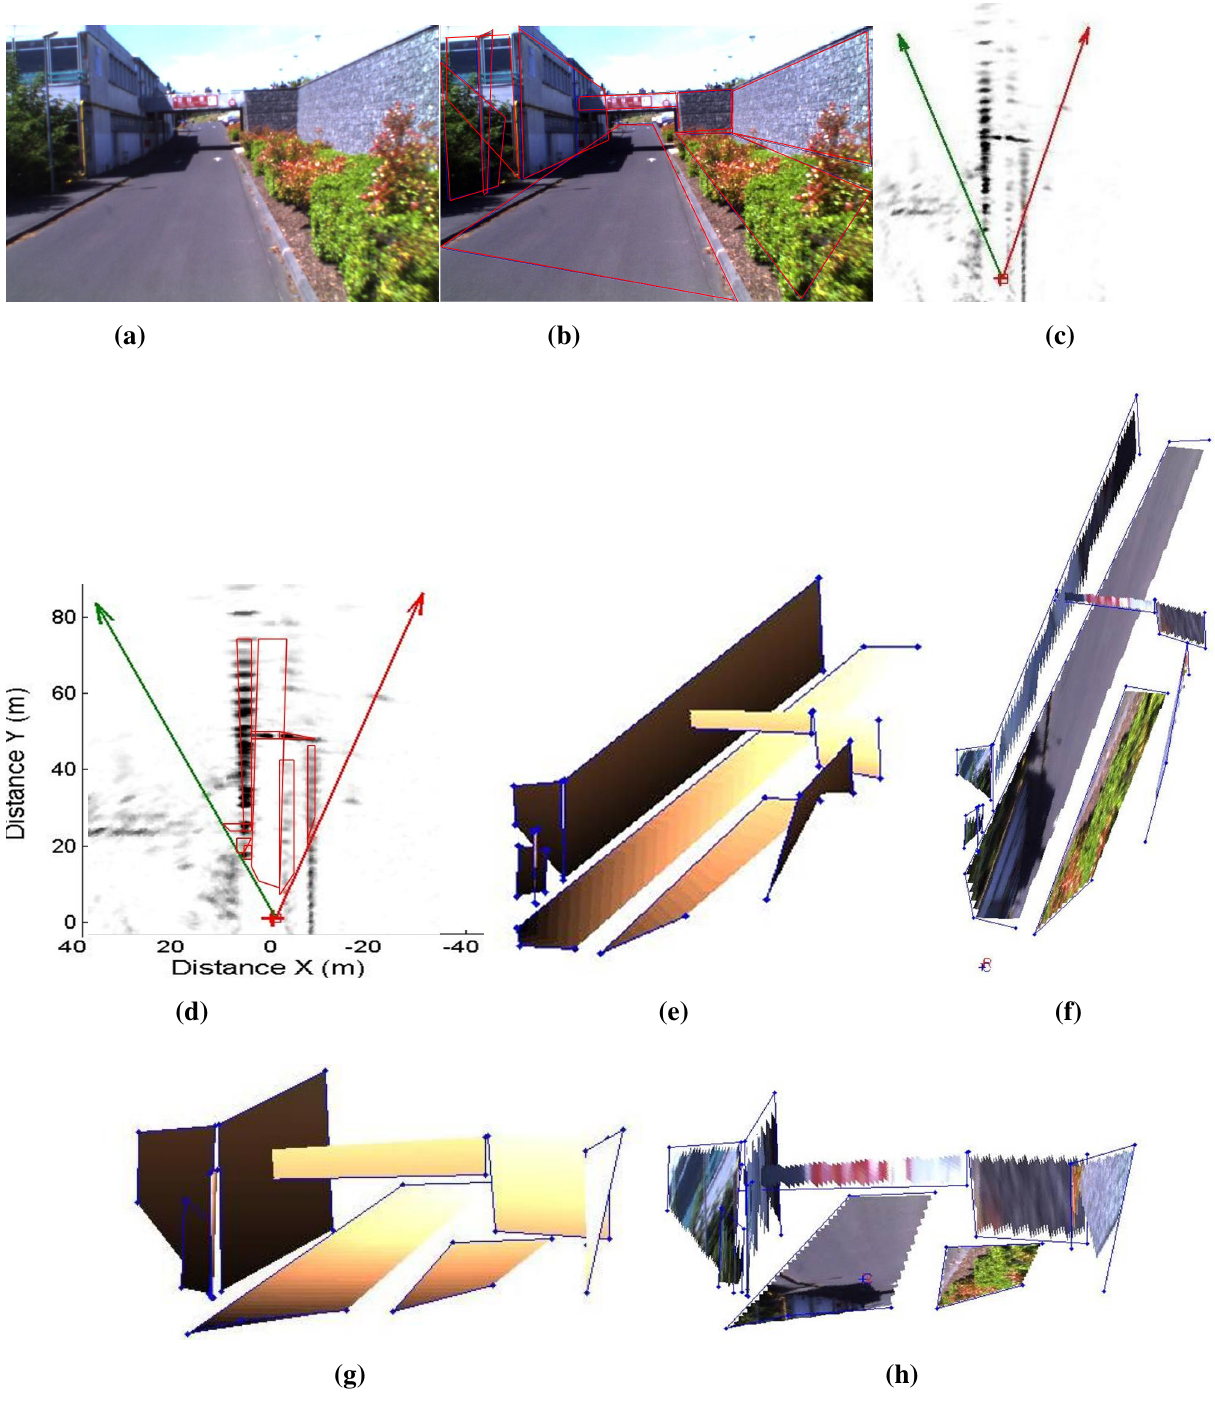
Figure 22. Results of a reconstructed urban scene using the camera/radar system and the second calibration method. The results are enhanced with texture mapping (this figure is clearer in color). ( a ) Camera image of an urban scene; ( b ) Segmented image (polygons are shown in red); ( c ) Part of the radar image of the same scene; ( d ) Segmented radar image; ( e ) Results of the reconstruction using Delaunay triangulation; ( f ) Enhanced results with texture; ( g ) Another view of the 3D results; ( h ) Another view of the 3D